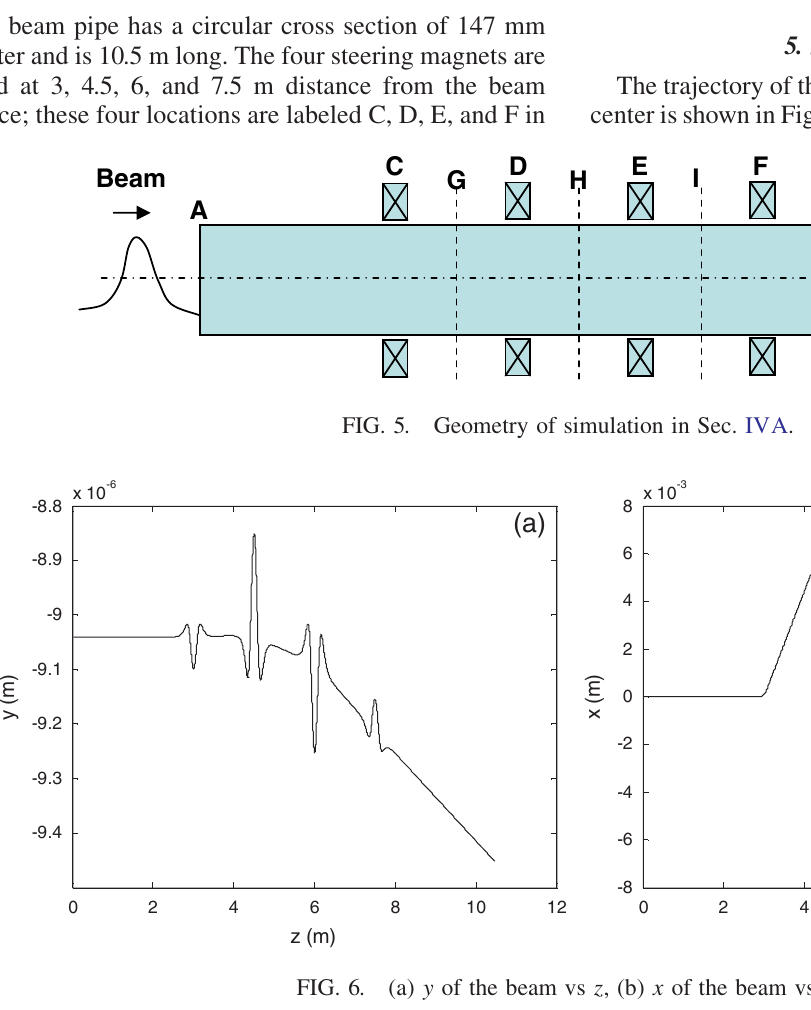
FIG. 6. (a) y of the beam vs z , (b) x of the beam vs z